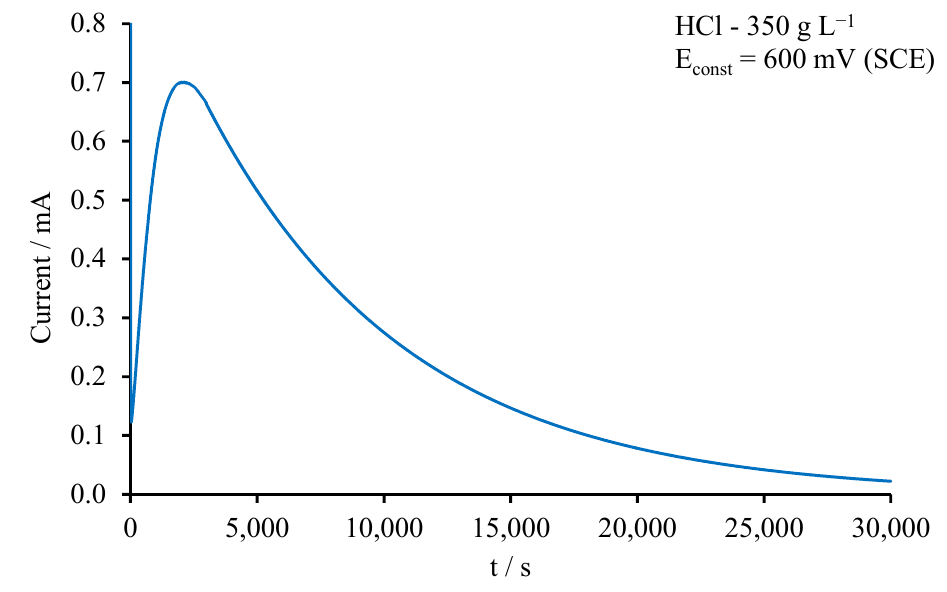
Figure 2. Chronoamperogram of tungsten–rhenium alloy dissolution. The samples of the tungsten–rhenium alloy after potentiostatic dealloying were sub- jected to X-ray phase analysis using a Rigaku D/MAX-2200VL/PC X-ray diffractometer (Rigaku, Japan) (Figure 3). It was found that after dealloying, new phases (for example, an oxide film) were not formed on the surface of the samples. This indicates the absence of the process passivation and favorably affects the depth of extraction of rhenium from the